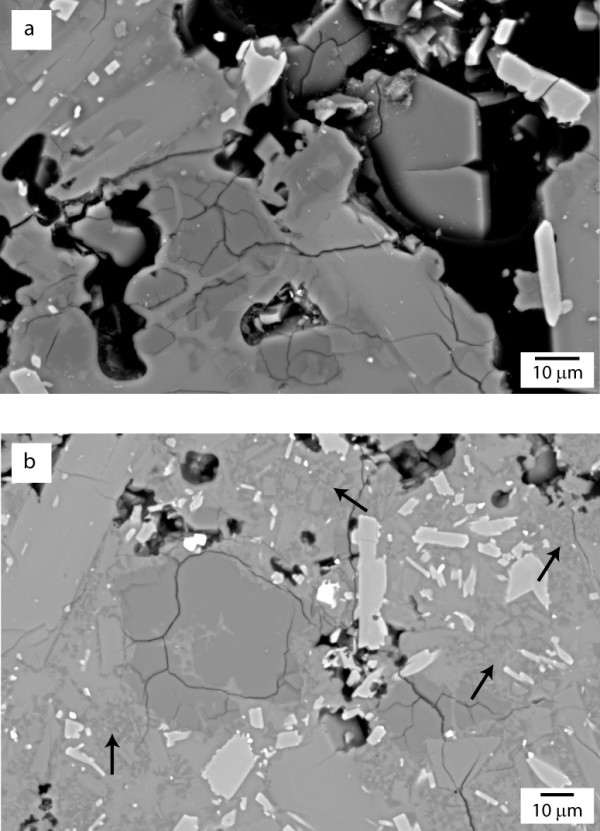
Backscattered electron (BSE) images showing cristobalite textures in thin section. a) Cristobalite crystal showing typical ‘fish-scale’ cracking in MVO1236. The boundary between the fish-scale cristobalite and surrounding groundmass is unclear. One platy crystal is protruding from a pore to the right, centre of the image; b) ‘Feathery’ groundmass texture (indicated by arrows) in MVO617, composed of cristobalite, glass and plagioclase feldspar (Horwell et al.
[12]) with associated fish-scale cristobalite which, in this case, is probably a product of extensive devitrification and also has a diffuse boundary.